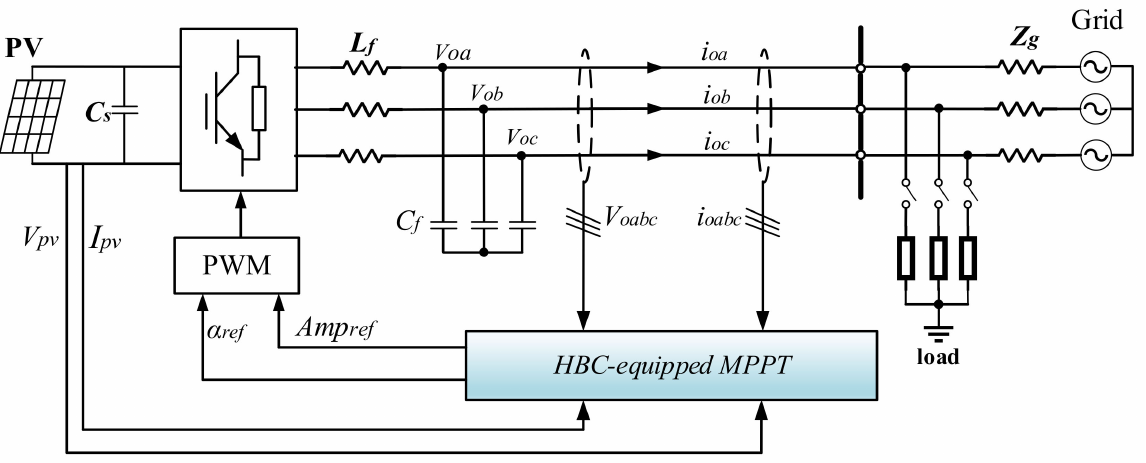
Figure 1. Grid-connected single-stage PV system